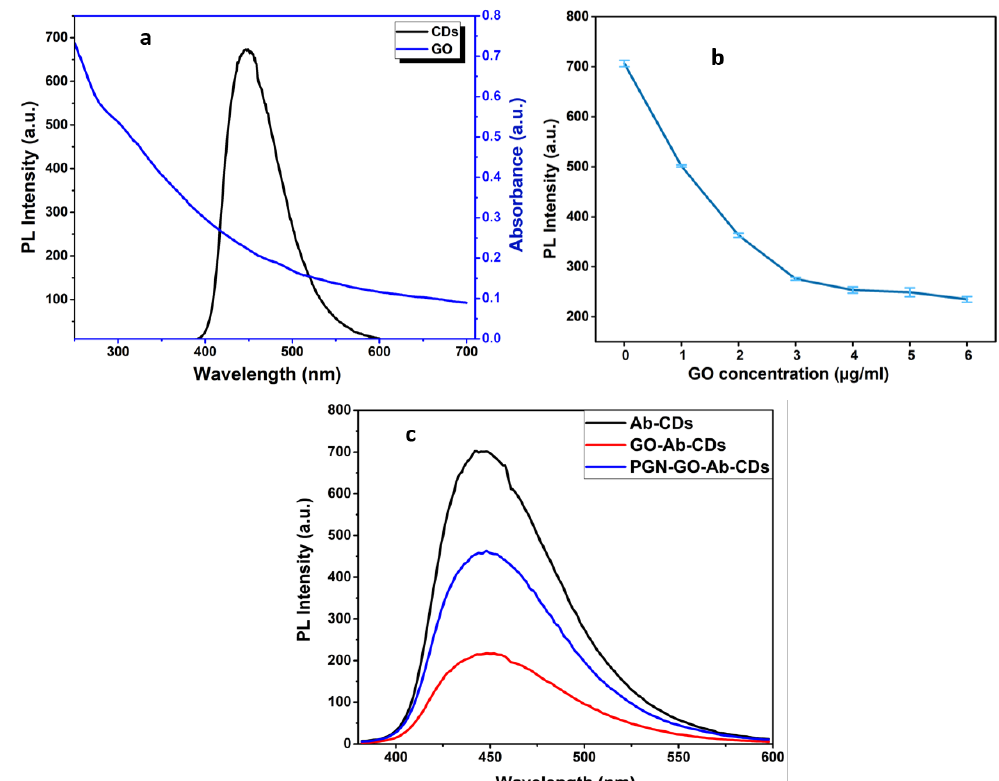
Figure 6. The overlapping absorbance of GO and emission of carbon dots ( a ), Investigation of the GO concentration for quenching efficiency ( b ) and Resultant PL spectra with and without the pres- ence of quencher, GO ( c ). quencher, GO ( c